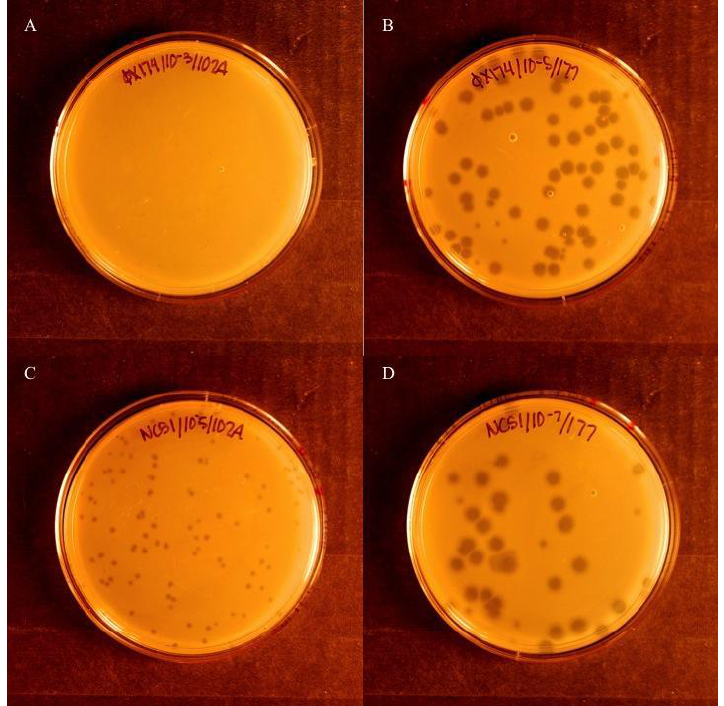
Figure 1. Visual comparison of phage isolates showing susceptibility to the reduction effect. ( A ) ΦX174 grown in the presence of the reduction effect plasmid, pΦX174rs. ( B ) ΦX174 grown in the presence of the control plasmid, pACYC177. ( C ) NC51 grown with pΦX174rs. ( D ) NC51 grown with pACYC177. ΦX174 grown in the presence of pΦX174rs ( A ) is susceptible to the reduction effect